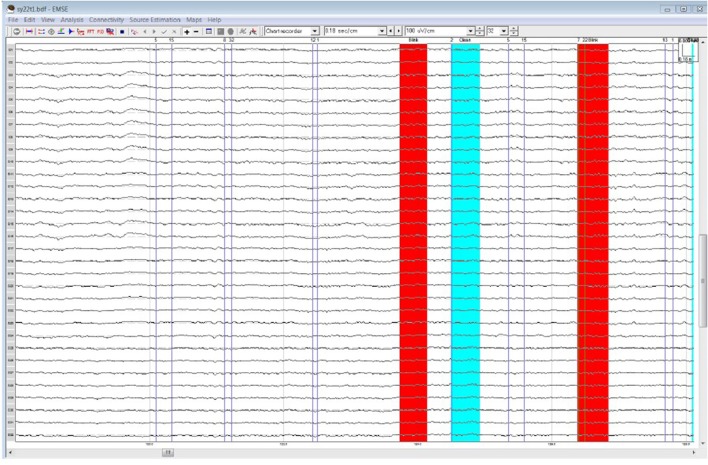
Processor A's selection of clean data (cyan) and blinks (red) within the frontal quadrant of the brain between 119 and 128 ms.